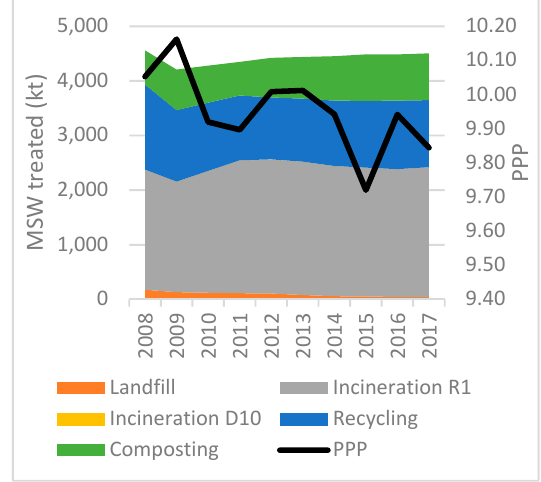
Figure 8. Waste treatment methods and PPP in Denmark 2008–2017 (EUROSTAT 2019b, 2019c).